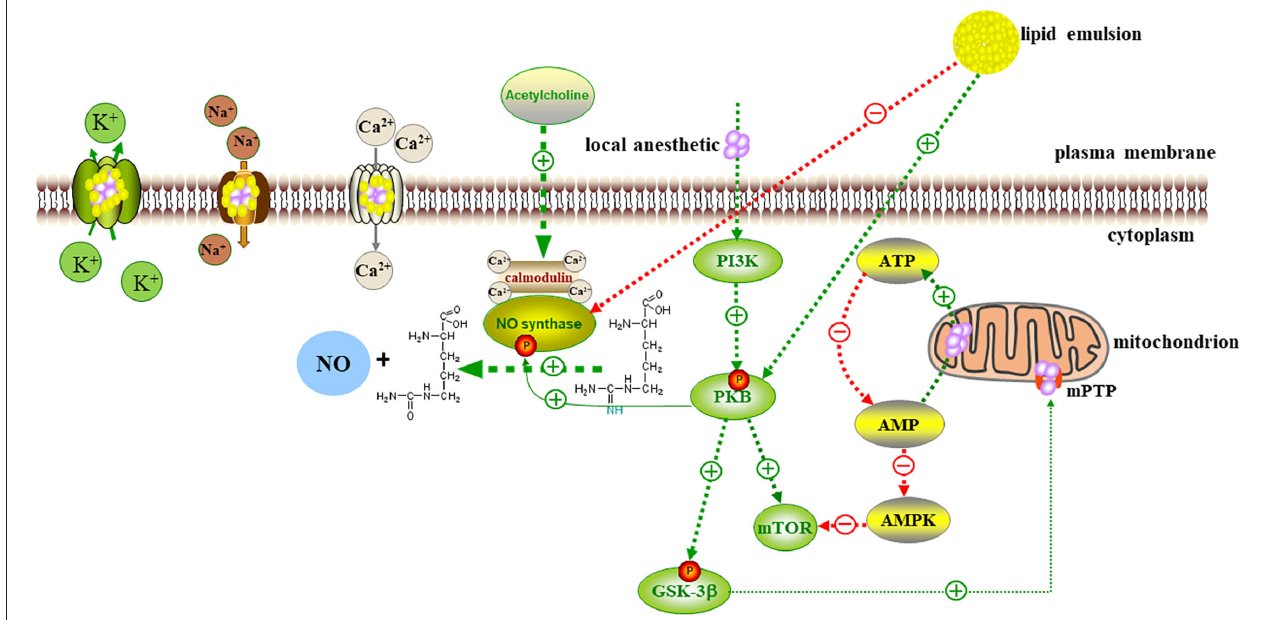
FIGURE 2 | Local anesthetics act on Na + , K + , Ca 2 + channels, interfere with signal transduction in cells and transmembrane cells, and inhibit the metabolic processes of PKB, AMPK, and other molecules related to cell survival and apoptosis. Local anesthetics increase the release of cytochrome c from mitochondria to cytoplasm, increased apoptosis, and impaired mitochondrial function. Lipid emulsion inhibited the opening of MPTP to restore mitochondrial function. Lipid emulsion can activate Ca 2 + channels, increase the intracellular calcium level, and activate upstream kinase PI3K, and PKB-mediated downstream kinase GSK-3 β Phosphorylation leads to the inhibition of MPTP opening, thereby reversing cardiomyocyte apoptosis induced by local anesthetics. Lipid emulsion inhibits the activation of eNOS, reduces the production and release of NO, and reverses the severe vasodilation caused by